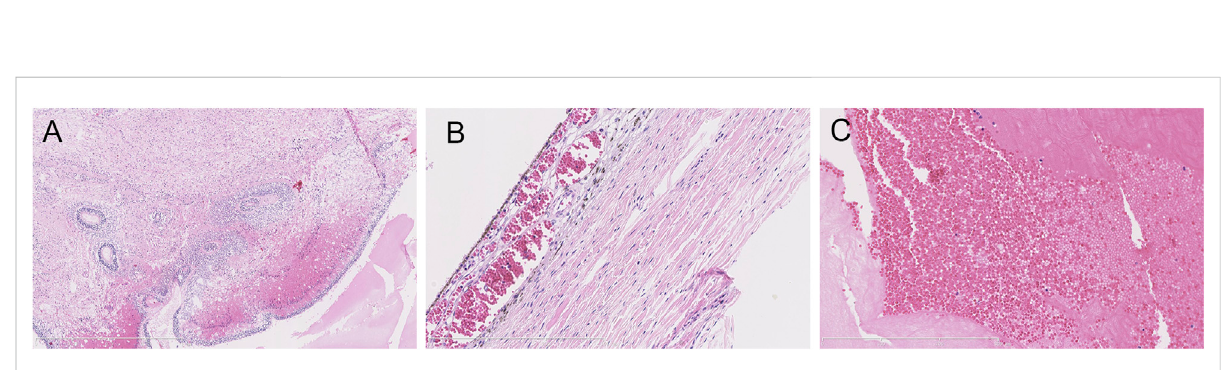
FIGURE 3 Histopathological examination of the eyeball by HE staining. (A) uveal and retinal degeneration and complete retinal detachment (lens, ×4). (B) massivebleedingandexudationcanbeseenundertheretina(lens,×120). (C) intraocular fi broustissuehyperplasiaanddegenerationandcrystal fi ber degeneration (lens,